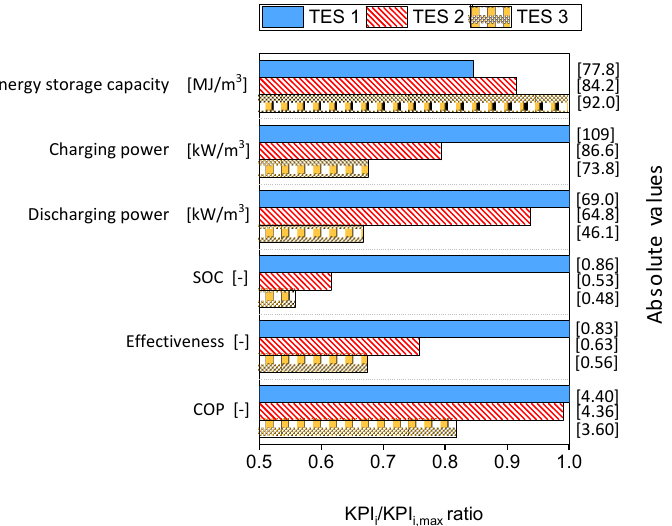
Figure 11. Summary of the key performance indicators of the modules.